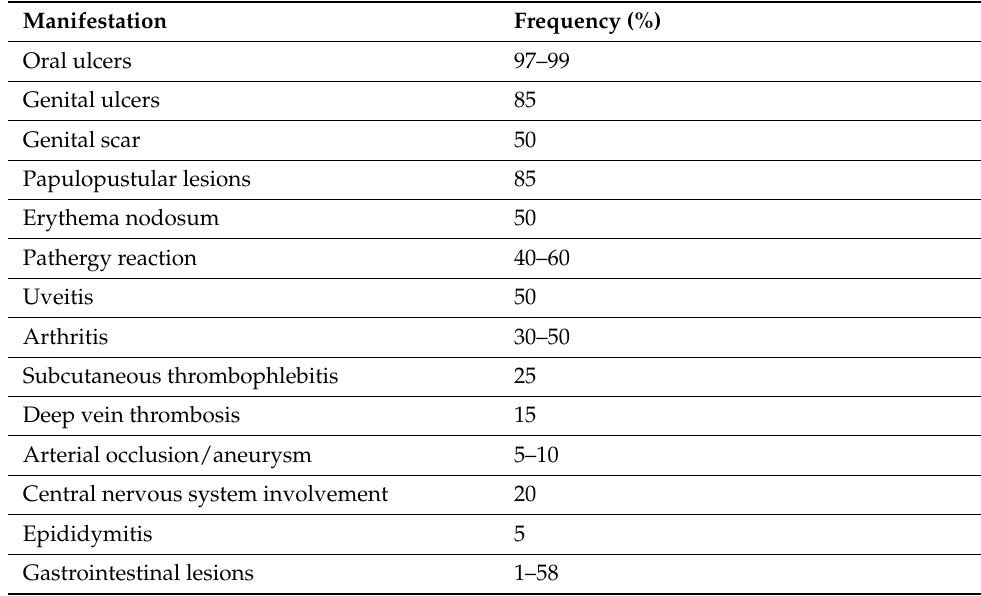
Table 1. Frequency of Behçet’s disease